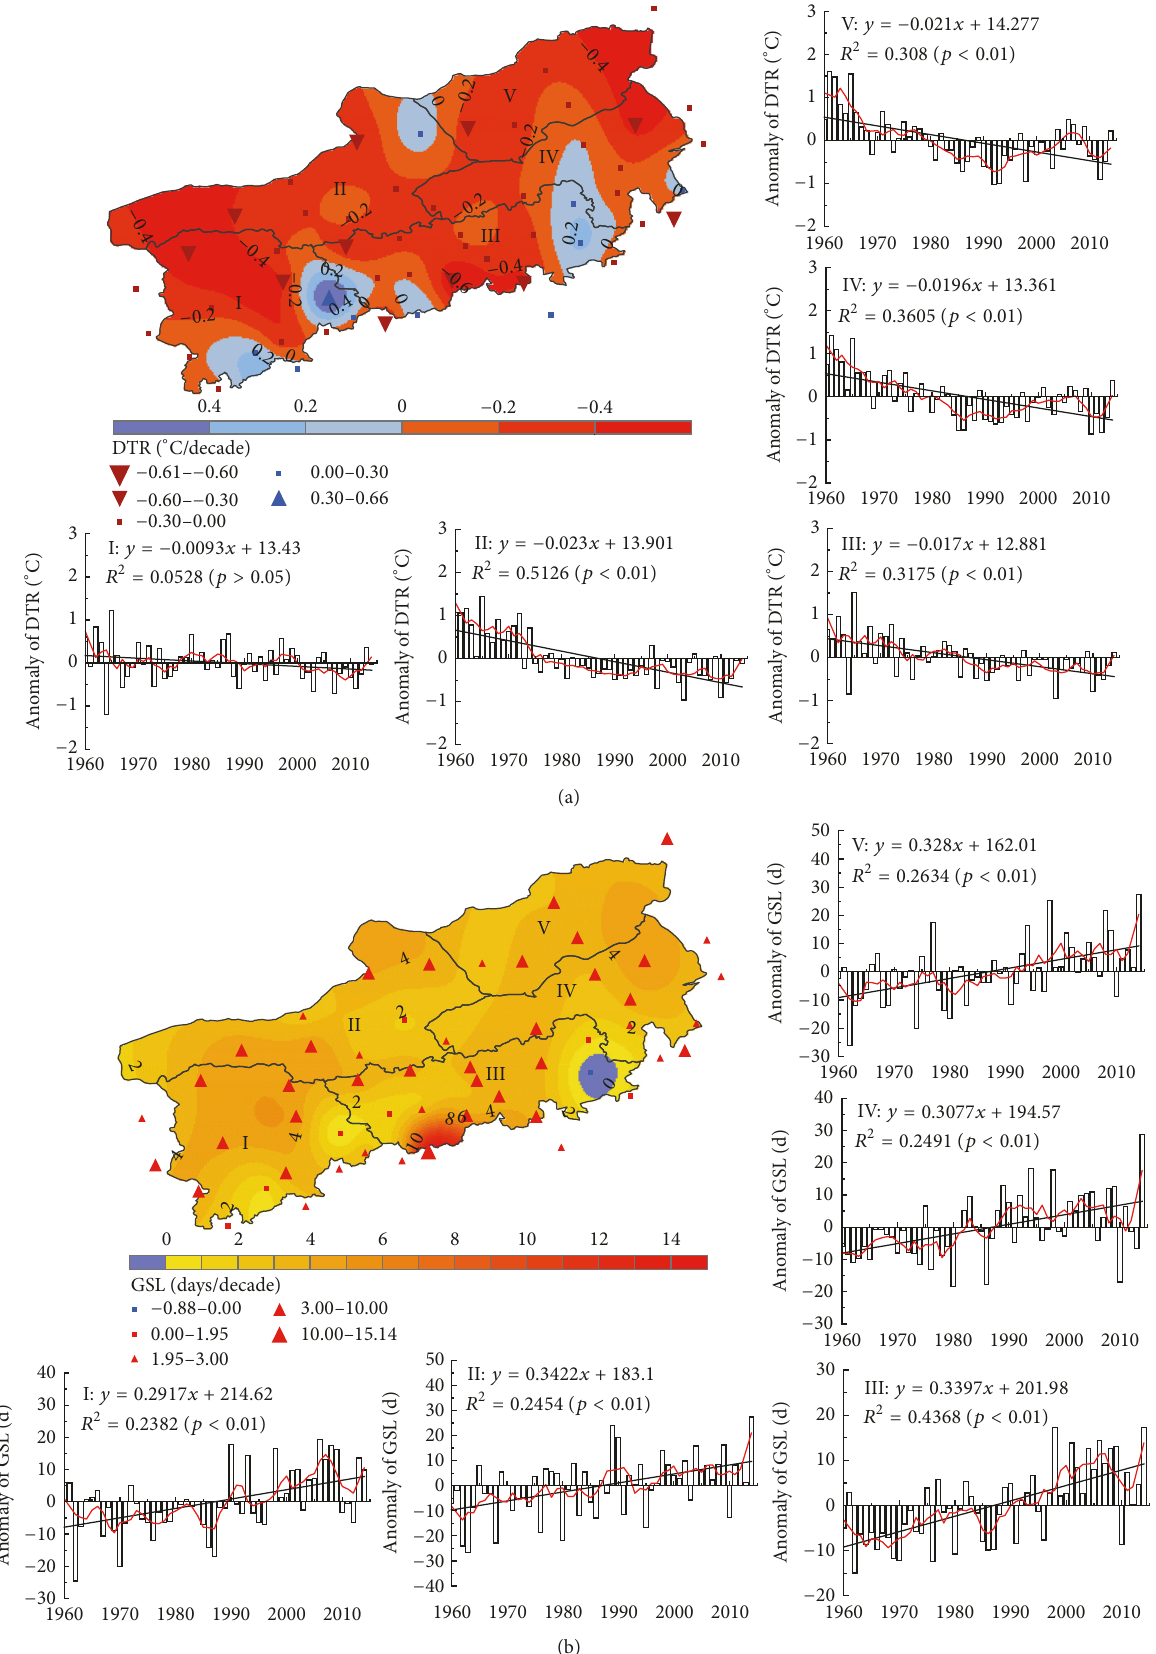
Figure 11: Spatial patterns of the trend slopes of variability indices over the BTSSR and anomaly of subregional indices curves, 1960–2014. The black line represents the linear trends for (a) DTR, (b) GSL. The redline represents 5-year moving